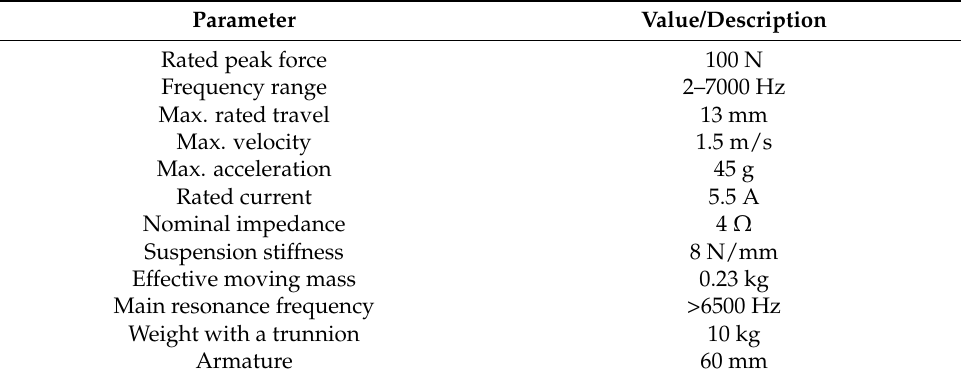
Table 2. Technical parameters of TIRA S513 vibration generator.